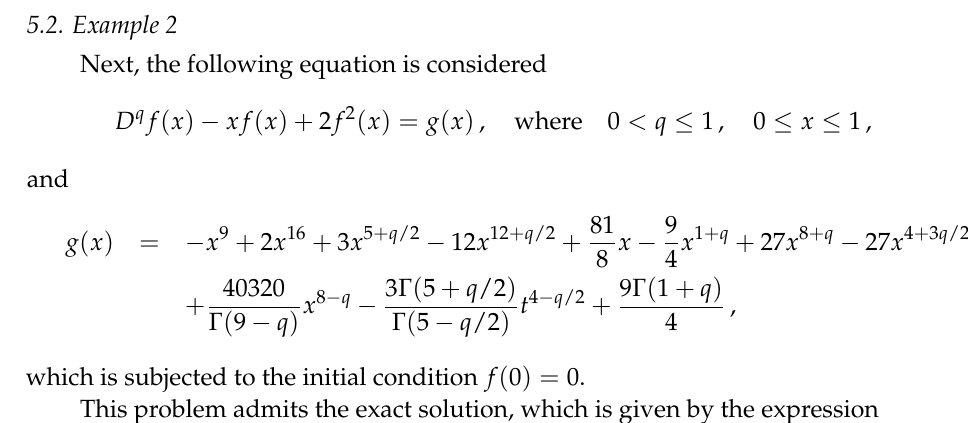
Figure 2. Exact and approximate solutions in Example 1, for q = 1 and α = 2.